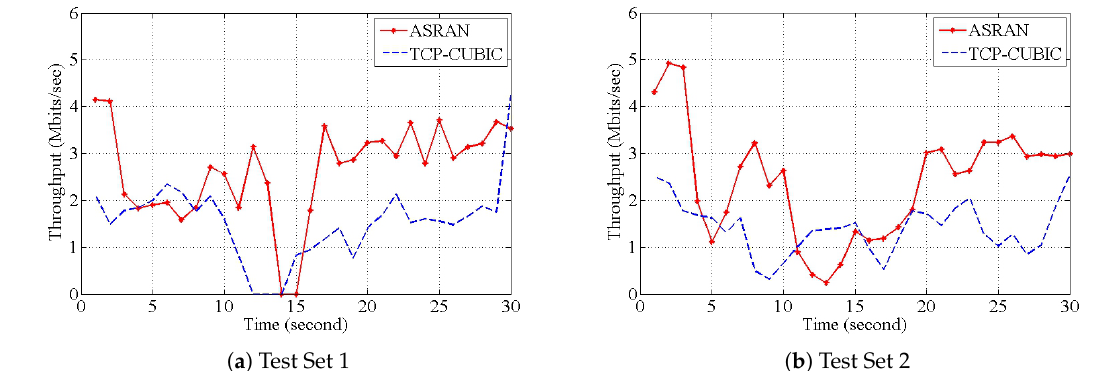
Figure 6. Throughput comparison of simultaneous experiment in heavy traffic environment.